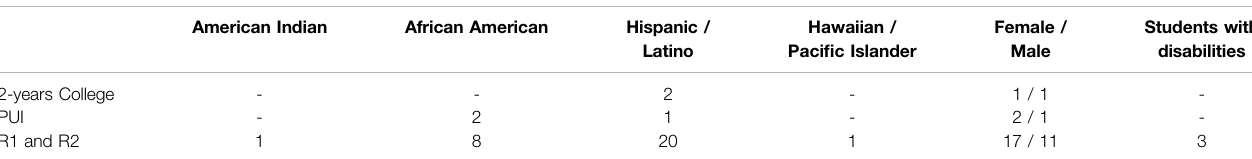
TABLE 1 | Demographics of Choose Development! fellows (2013 –